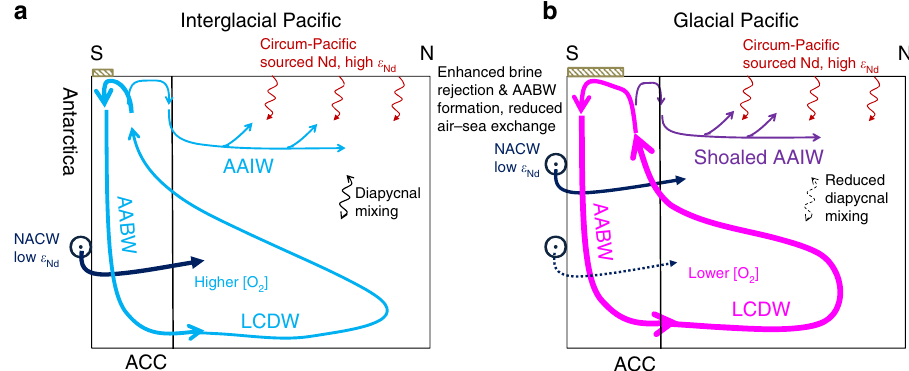
Fig. 8 The Paci fi c overturning schematics during the G – I states. a Interglacial sketch. b Glacial sketch. The vertical black line bounds the northernmost extension of the ACC. Line colours from dark blue, light blue to purple, pink and red indicate increasing ε Nd values: dark blue North Atlantic Component Water (NACW) with low ε Nd values, red circum-Paci fi c Nd sources with radiogenic ε Nd values. Line thickness changes among panels denote changes in fl ow fl ux/rate. The red wavy arrows show the addition of circum-Paci fi c Nd sources with radiogenic ε Nd values from the upper ocean to the deep ocean. The black wavy arrows show the diapycnal mixing between different depths. Today, the Atlantic component water with low ε Nd compositions is propagated into the deep Southern Ocean and incorporated into the LCDW via the ACC. During the glacial periods, with the build-up of sea-ice and enhanced brine rejection, the formation rate of AABW may have increased